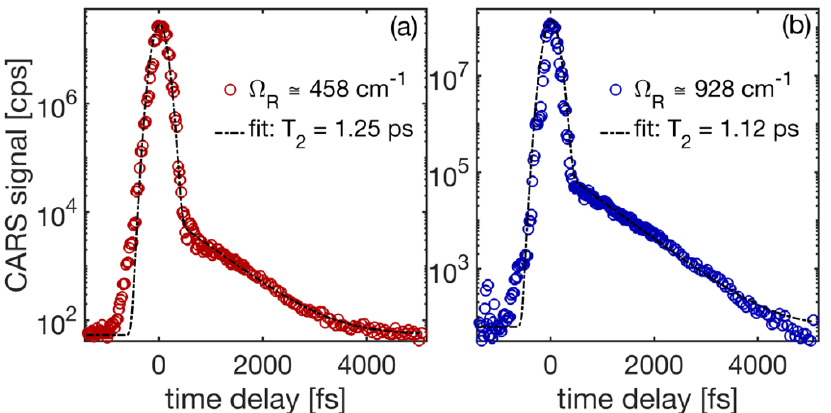
Figure 3. The time-resolved CARS signals obtained from the SrTiO 3 single crystal while favoring LO 3 ( a ) and LO 4 ( b ) phonon mode excitations. The OPO 1 central wavelength was fixed at ~1015 nm, while the OPO 2 wavelengths were tuned to ~1063 nm and ~1109 nm, correspondingly. The phonon decay time constant values ( T 2 ), indicated in the legend, were obtained from the best-fitting results (dash-dotted curves).